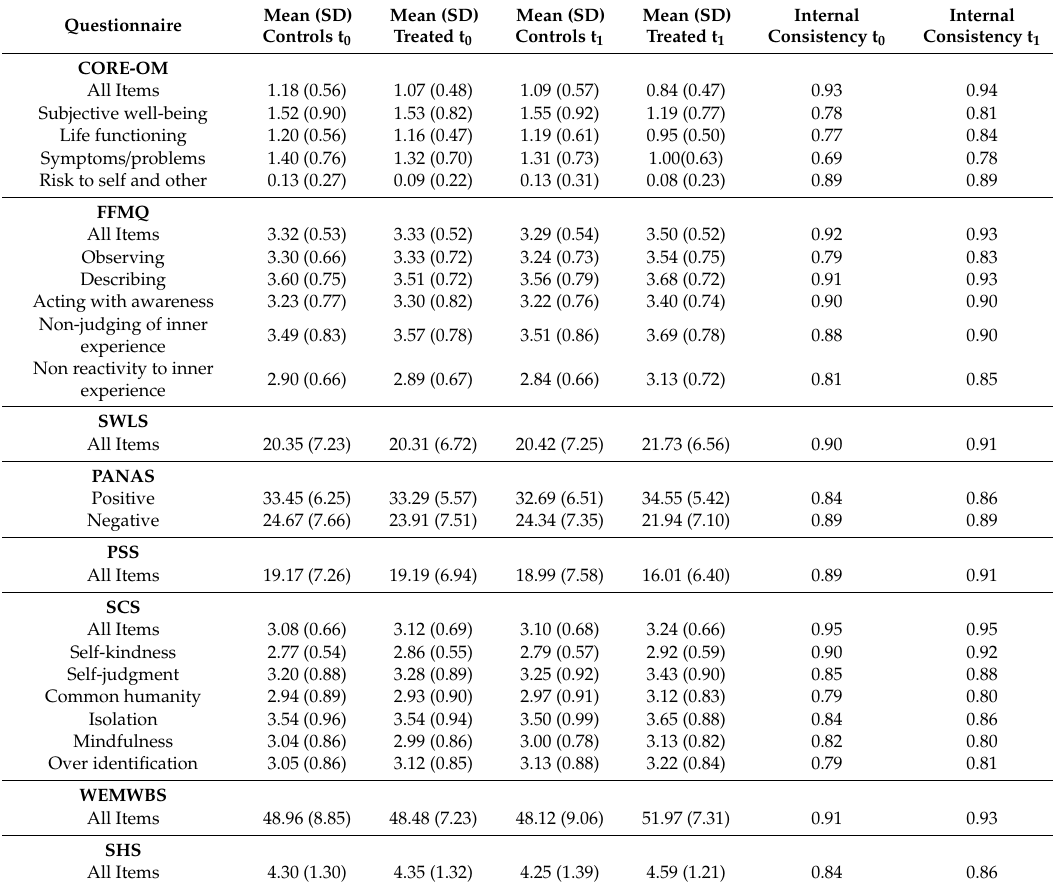
Table 2. Mean, standard deviation (SD) and internal consistency for each questionnaire and subscale in the two groups (controls and treated) at both time points (t 0 and t 1